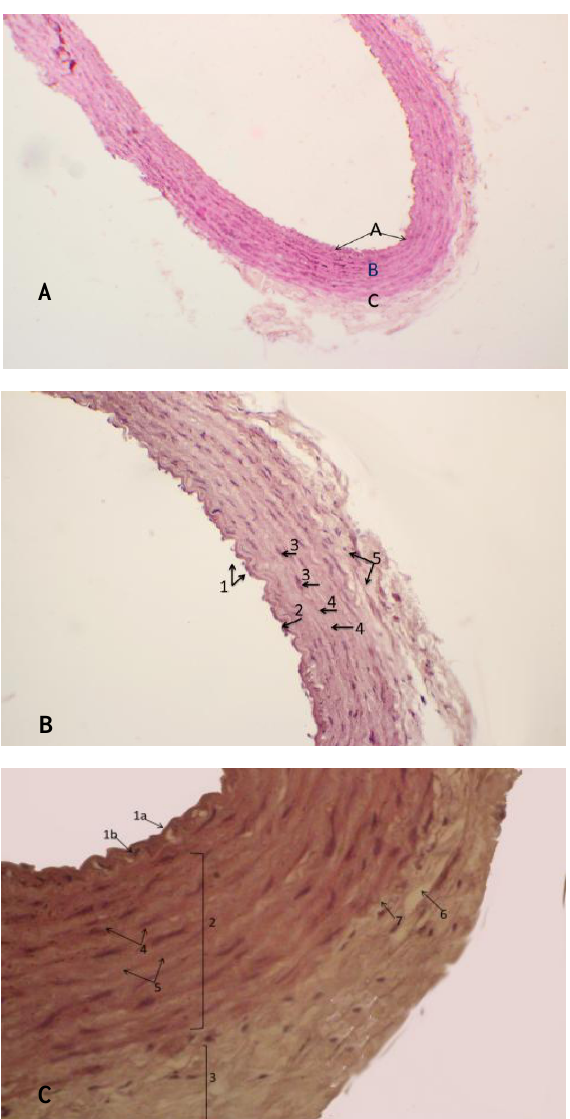
Figure, 6: The histological structure of Aortic arch in rabbits showing: (6a) (A) Tunica intima (B) Tunica media (C) Tunica adventitia (100x) H and E stain. (6b) (1) Endothelial layer cells (2) Internal elastic lamina (3) Smooth muscle cells (4) Elastic fibers lamina (5) connective tissue. (2oo x) H and E Stain. (6c) (1a) Endothelial cells layer (1b) Internal elastic lamina (2) Tunica media (3) Tunica adventitia (4) Smooth muscle cells (5)Elastic fibers lamina (6) vasa vasorum (7) external elastic lamina (400 x) H and E